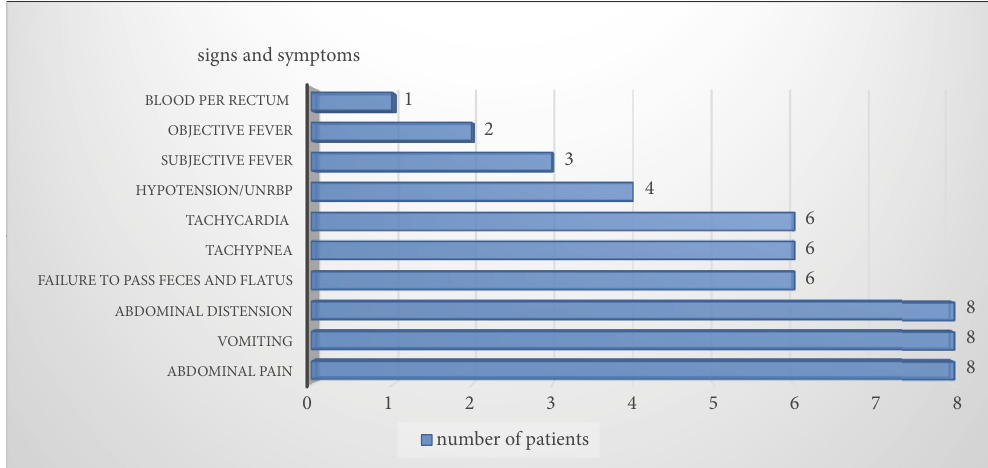
Figure 1: Clinical symptoms and signs on presentation of patients with fatal gastrointestinaland peritoneal ischemicdisease discussed in this case report. UNRBP: unrecordable blood pressure.